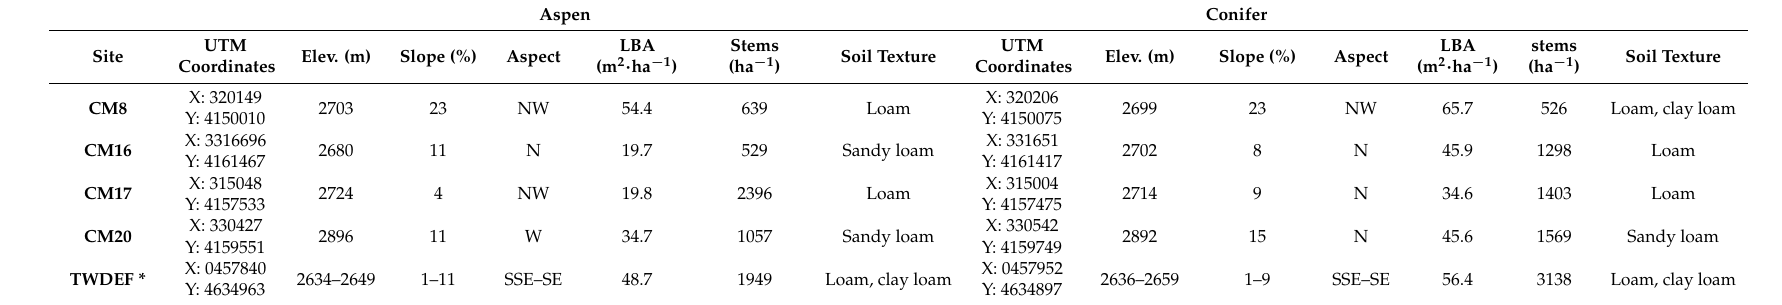
Table 1. Site location and stand